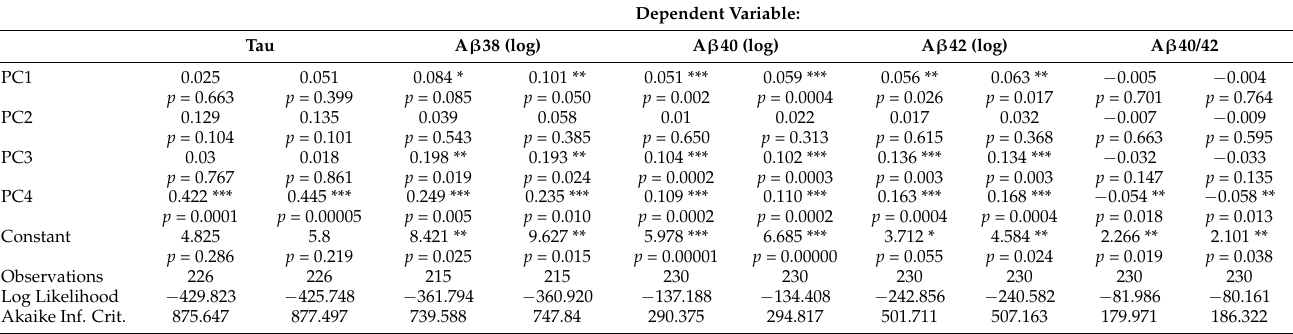
Table 2. Associations between principal components of oxidative stress and inflammation and AD biomarkers in the